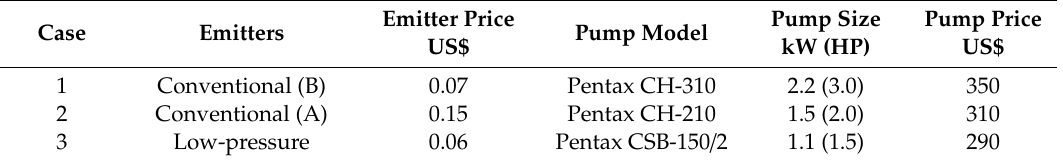
Table 4. Summary of assumptions in modeled cases with three di ff erent emitter types. Prices for emitters and pumps were supplied by local contractors and Jain Irrigation,